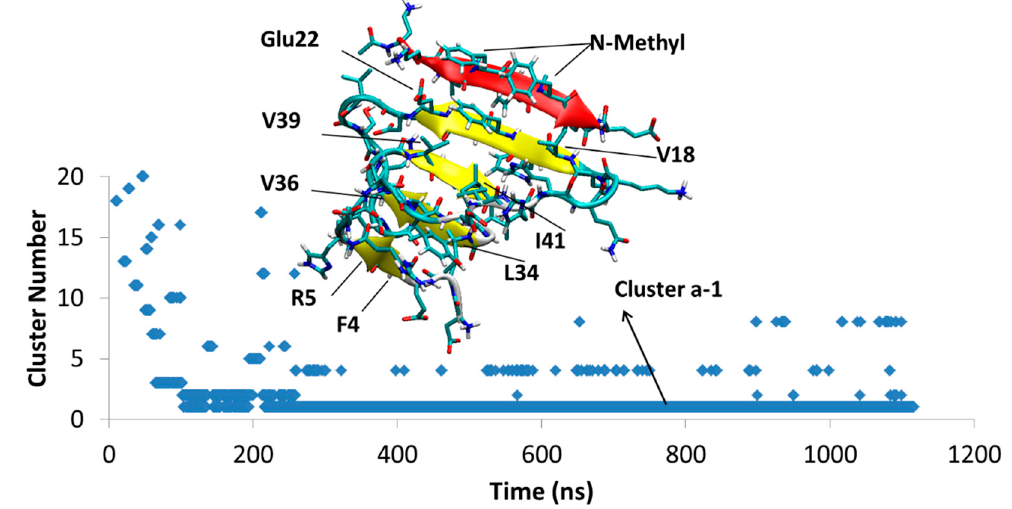
Figure 5. A β 42T -SGB1-a; The cluster Ba1 structure is shown, which persist through almost 1 µ s. The vertical axis is the cluster number count based on population, where cluster 1 has the highest population. The horizontal axis is simulation time in nanoseconds.